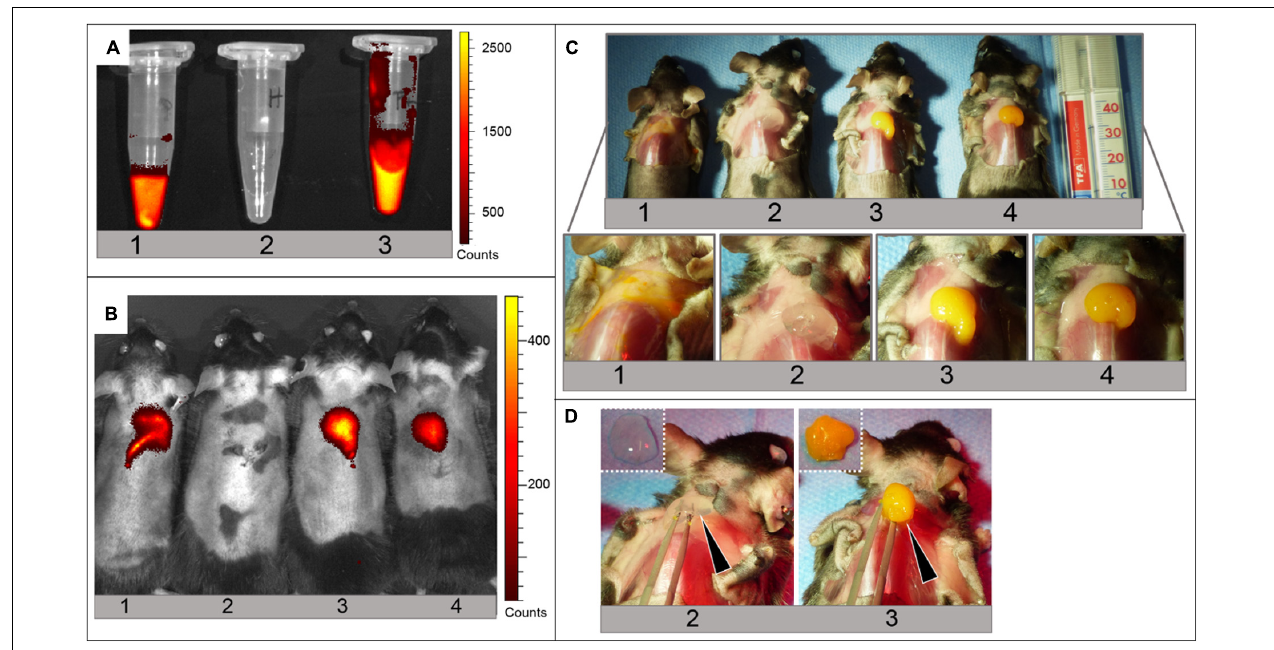
FIGURE 7 | Injection and gelation of MSN-CS-SIP-Ru aqueous dispersion, SHP407 hydrogel and SHP407_MSN-CS-SIP-Ru hybrid hydrogel in situ into murine cadavers. (A) IVIS read at ex/em filter: 465 nm/ Cy5.5 of MSN-CS-SIP-Ru aqueous dispersion (1), SHP407 hydrogel (2) and SHP407_MSN-CS-SIP-Ru hybrid hydrogel (3) before injection in the animal model. (B) IVIS read at ex/em filter: 465 nm/ Cy5.5 of murine cadavers with maintained physiological body temperature subjected to injection of MSN-CS-SIP-Ru aqueous dispersion (1) , SHP407 hydrogel (2) and SHP407_MSN-CS-SIP-Ru hybrid hydrogel (3,4) . Only those animals injected with samples containing Ru-loaded MSN-CS-SIP exhibited a fluorescence signal. (C) Photographic images of the animals previously measured in the IVIS (same numbering) including a magnification of the injection site. Solid materials can be seen in animal (2–4) , whereas MSN-CS-SIP-Ru were broadly dispersed in the animal injected with particle suspension (animal 1). (D) Test of gelation of SHP407 (animal 2) and SHP407_MSN-CS-SIP-Ru (animal 3) by lifting the material up (black arrows). The solid form was maintained after the harvest (dashed pictures, top left of each